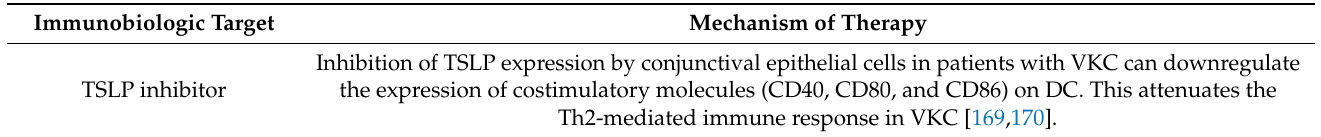
Table 2. Summary of immunobiologics and potential therapeutic mechanisms against